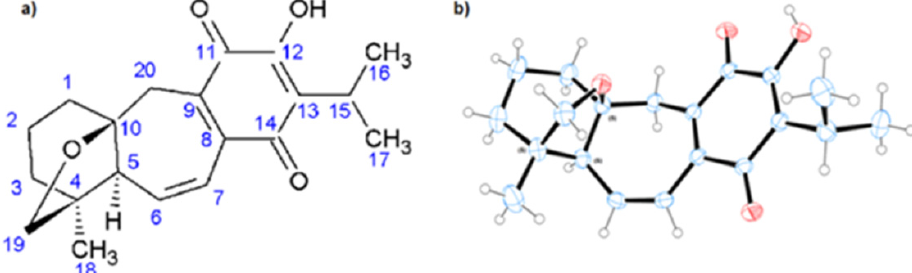
Table 1. NMR spectroscopy data for 19-deoxyicetexone (600 MHz. CDCl